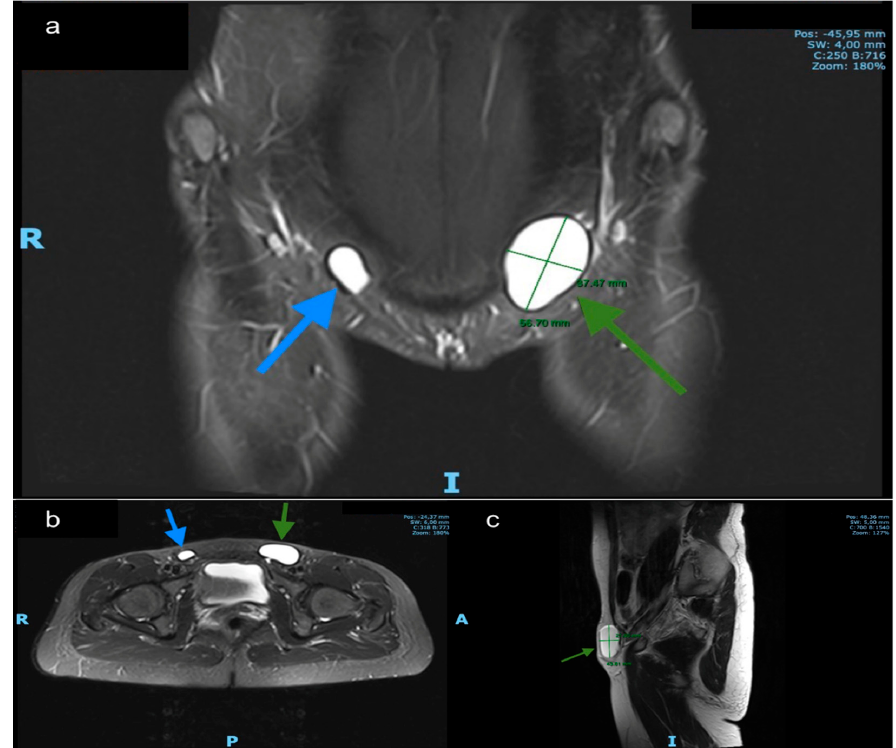
Figure 3. MRI findings. ( a ) Coronal T2-weighted. ( b ) axial T2-weighted and ( c ) sagittal MR images demonstrate a left inguinal hyperintense cystic structure without septation and a smaller (asymptomatic) on the right side. Green arrows: left hydrocele, blue arrows: right hydrocele.